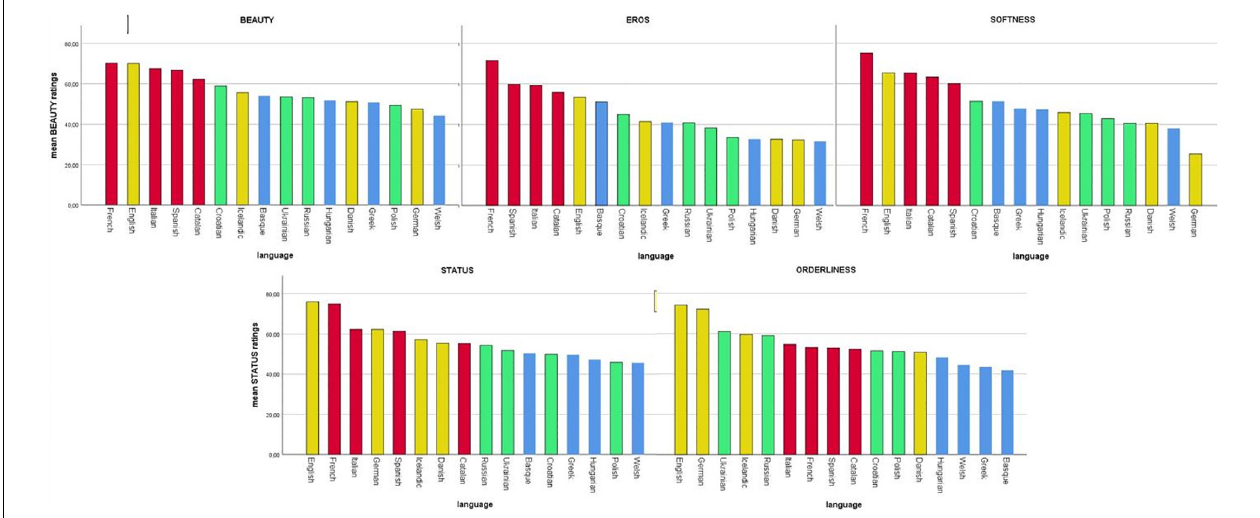
FIGURE 2 | Aesthetic ratings, grouped by factors (Beauty, Eros, Softness, Status, and Orderliness), for all 16 languages, colored by language families (red = Romance, yellow = Germanic, green = Slavic, and blue = other).